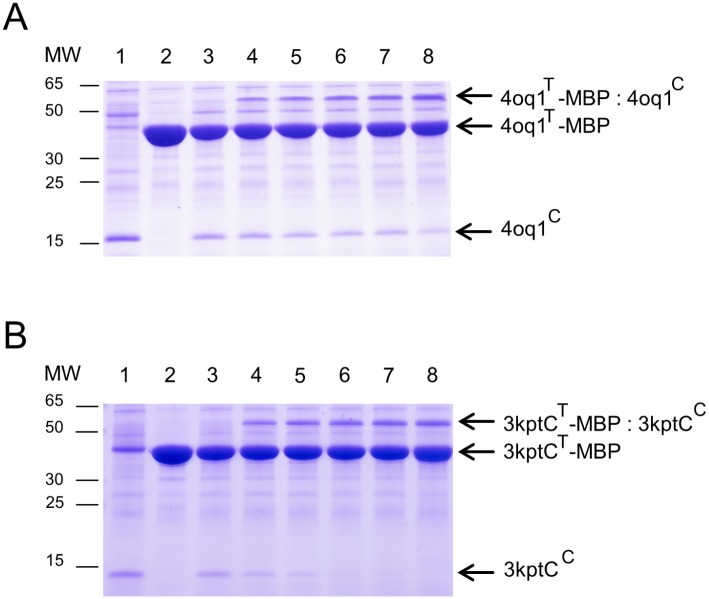
Covalent intermolecular bond formation assays for 4oq1C / 4oq1T-MBP (A) and 3kptCC / 3kptCT-MBP (B).(A) Purified 4oq1T-MBP and 4oq1C were mixed each at 15 μM (final concentration) for 24h at 25°C with shaking at 500 rpm before boiling (10min, 95°C) and SDS-PAGE with Coomassie staining. 4oq1T-MBP and 4oq1C reacted spontaneously to form a covalent product increasing over time (lane 1: catcher input (30μM), lane 2: tag input (30μM), lane 3: 0h, lane 4: 1h, lane 5: 2h, lane 6: 3h, lane 7: 4h, lane 8: 24h). Same volume of samples were loaded. MW stands for molecular weight (kDa). (B) Bond formation assay monitoring the reaction of 3kptCT-MBP and 3kptCC. All experimental settings as described in (A).